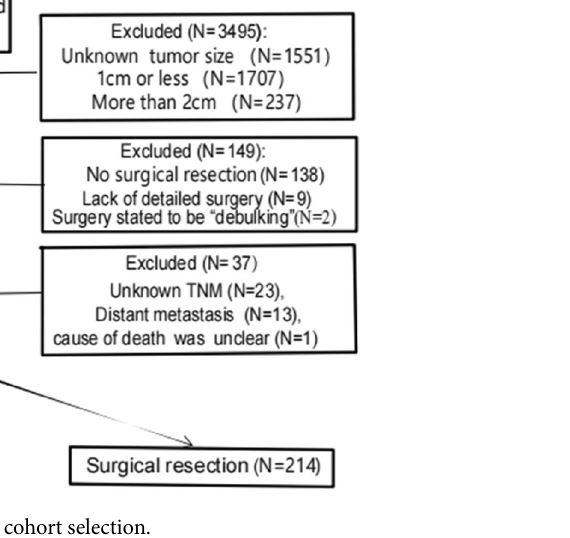
Figure 1. Flow chart of patient cohort